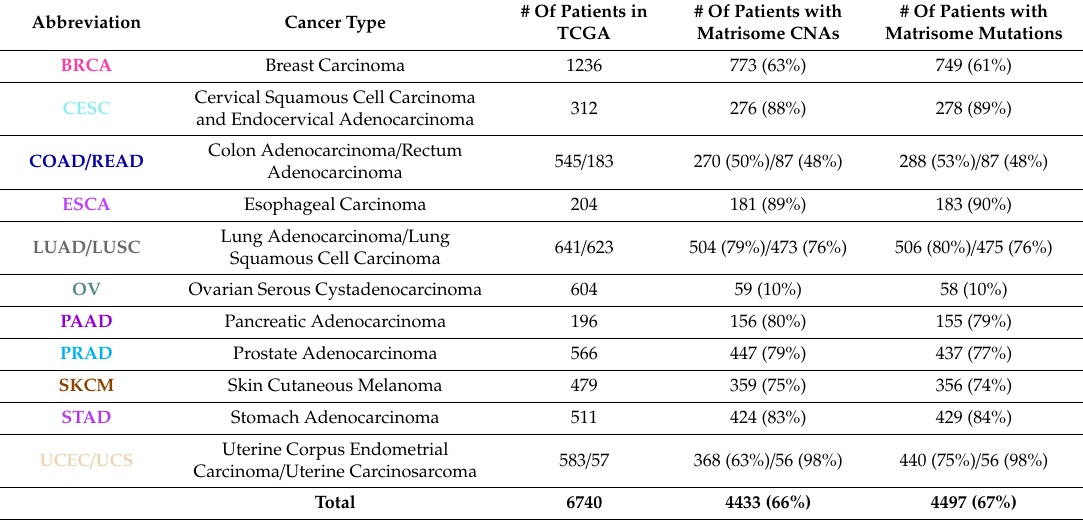
Table 2. Number of patients included in the meta-analysis and number of patients for which copy number alterations (CNAs) or mutations in matrisome genes were